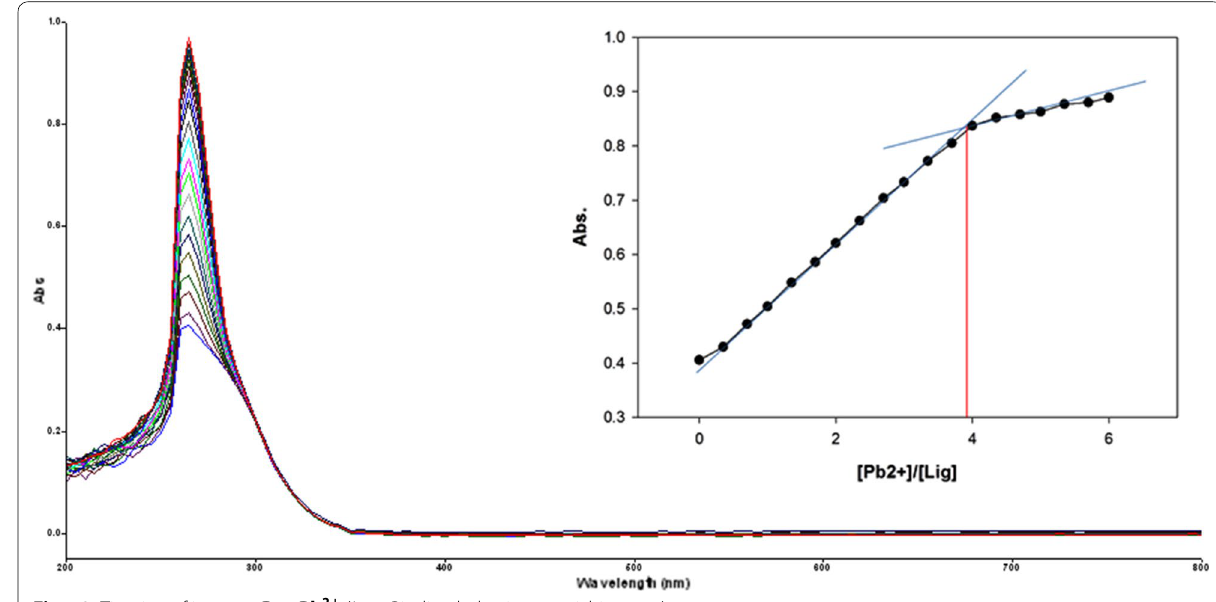
Fig. 13 Titration of isomer 1B vs Pb 2 + ( Inset Binding behavior